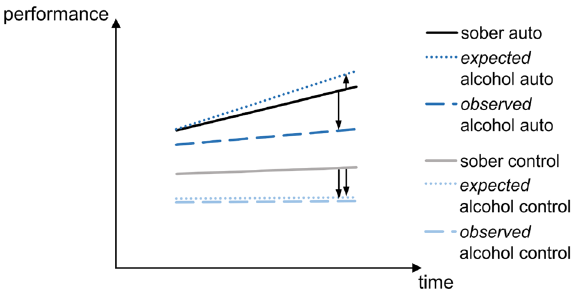
Figure 4. Schematic illustration of expected vs. observed alcohol intoxication effects on automated vs. controlled motor response sequence generation, as compared to sobriety. We had expected and also observed alcohol-related impairments in controlled motor response sequence generation. Furthermore, we had expected the automatization of response sequences to be relatively preserved during intoxication. In contrast to our initial hypothesis, we however observed impaired automatization of motor response sequences during acute